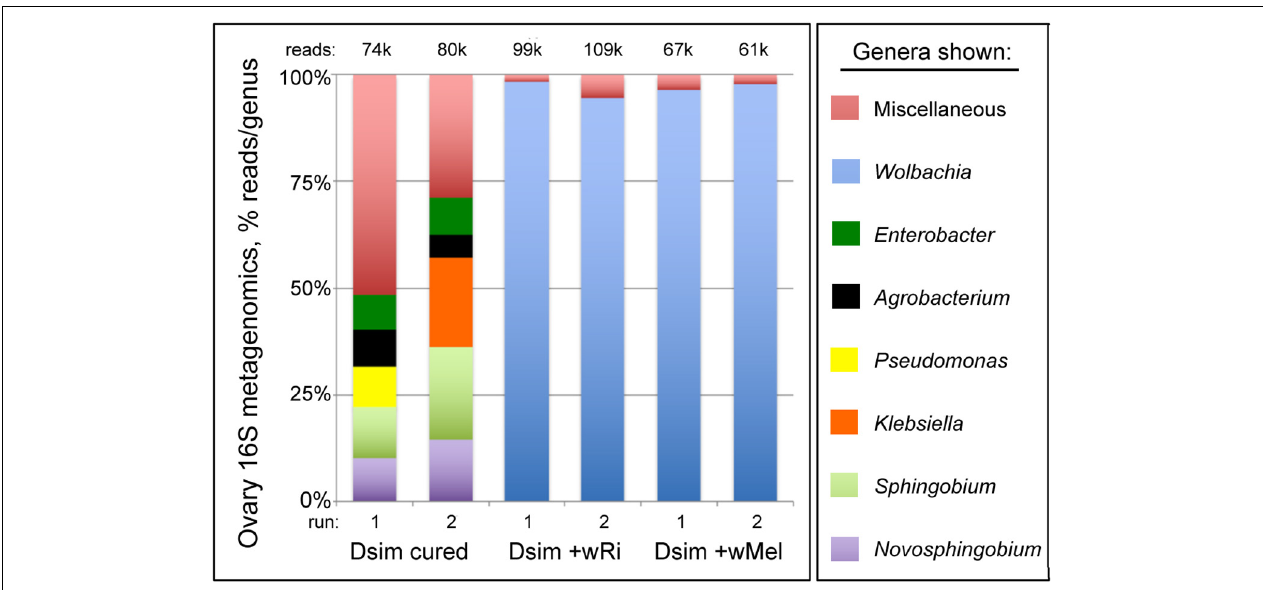
FIGURE 1 | 16S rRNA microbiome profiles associated with Drosophila simulans ovary tissues. Uninfected and Wolbachia -infected tissues are shown. Top five most abundant genera that equal or exceed 1% abundance per sample are shown. For further details, see Supplementary Table S1 and Additional File